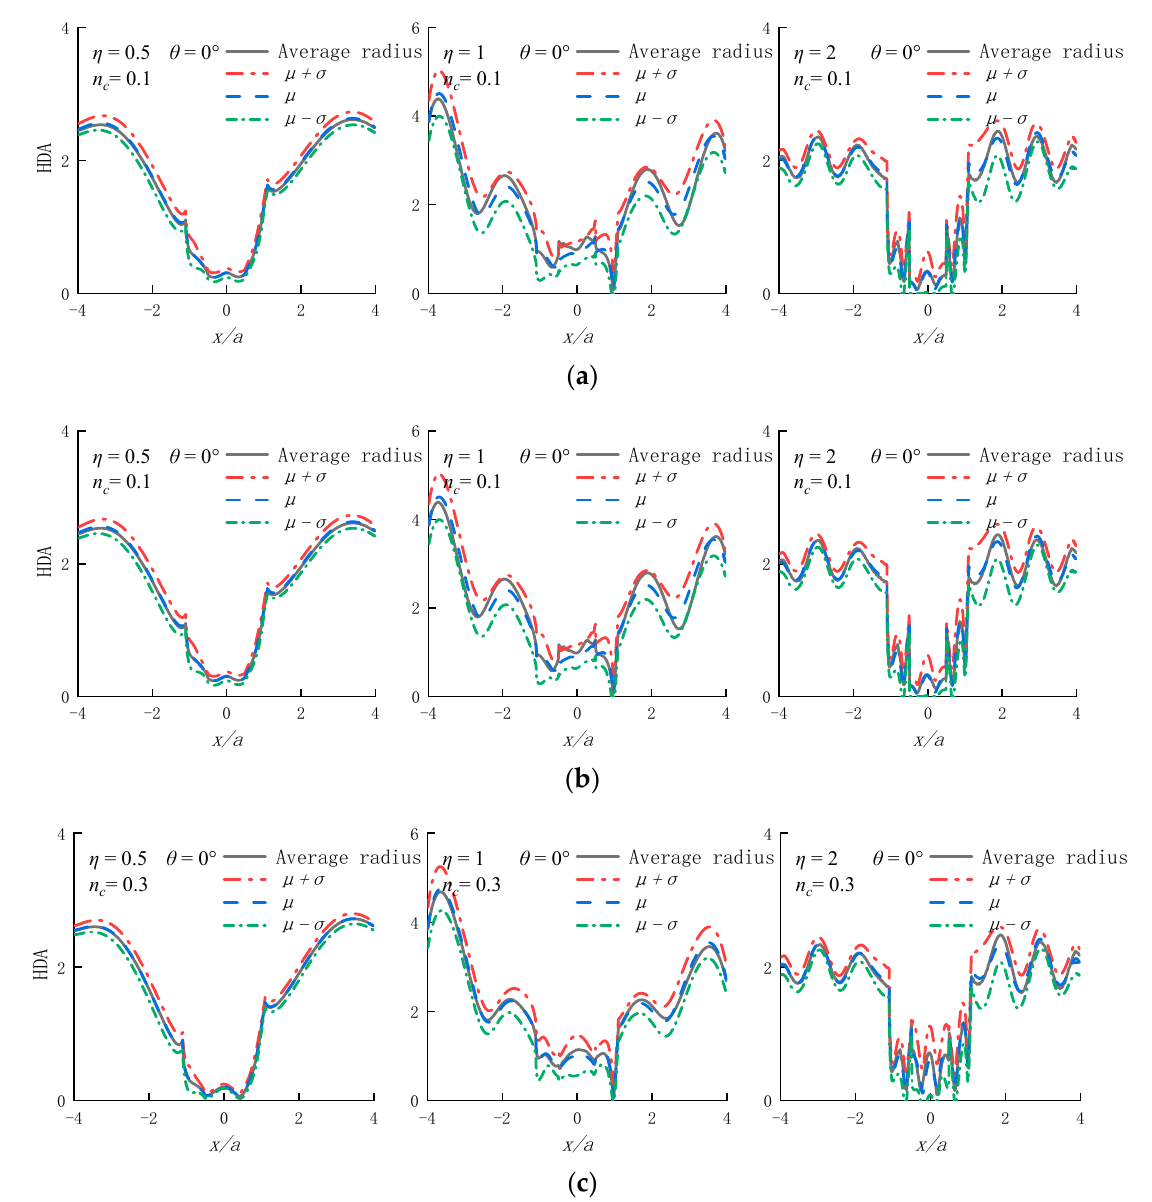
Figure 8. Horizontal surface displacement amplitude ( θ = 0 ◦ ) . ( a ) n c = 0.1; ( b ) n c = 0.2; ( c ) n c = 0.3. When the SV wave is incident, the spatial distribution characteristics of displacement are significantly different at different frequencies. As shown in Figure 8, when the di- mensionless frequency increases, the change of the amplitude of surface displacement is more complex. When the dimensionless frequency η is from 0.5 to 2, the amplitude of sedimentary displacement is magnified by 4.67 times ( n c = 0.1), 5.85 times ( n c = 0.2), and 12.52 times ( n c = 0.3), respectively. The results show that the change of sedimentary porosity has little effect on the amplitude at low frequency. At high frequency, with the increase in sedimentary porosity, the amplitude of surface displacement increases, and the amplitude of sedimentary displacement oscillates and increases. When the porosity of the sedimentary medium is close to the critical state, the variation of surface displacement is more complex. When porosity n c = 0.2 or 0.3, the magnification also increases gradually. The results show that with the increase in frequency and porosity, the confidence interval of displacement amplitude becomes wider and the discreteness becomes